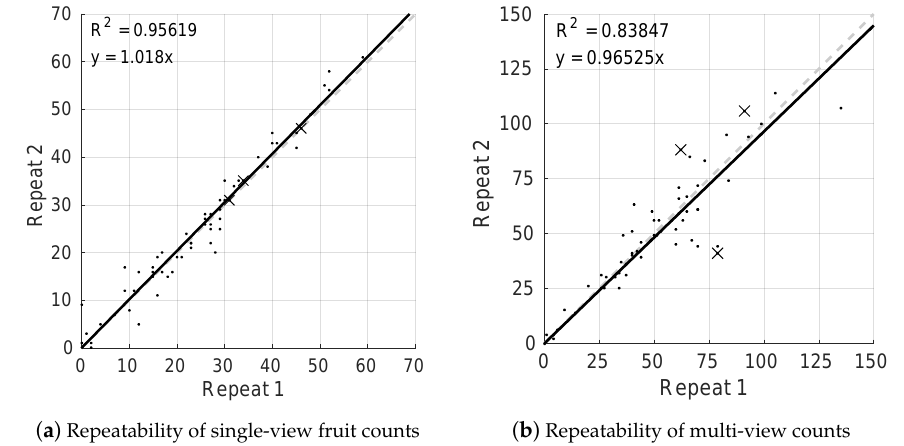
Figure 12. Repeatability of ( a ) single and ( b ) multi-view fruit count estimates for one side of orchard Row 5. A line is fitted to the data, and the respective R 2 -value and slope are shown in the figure. The dashed line denotes the expected line of equality. Three significant outliers marked by crosses in ( b ) are investigated further in Section 4. They are included in the R 2 calculation.